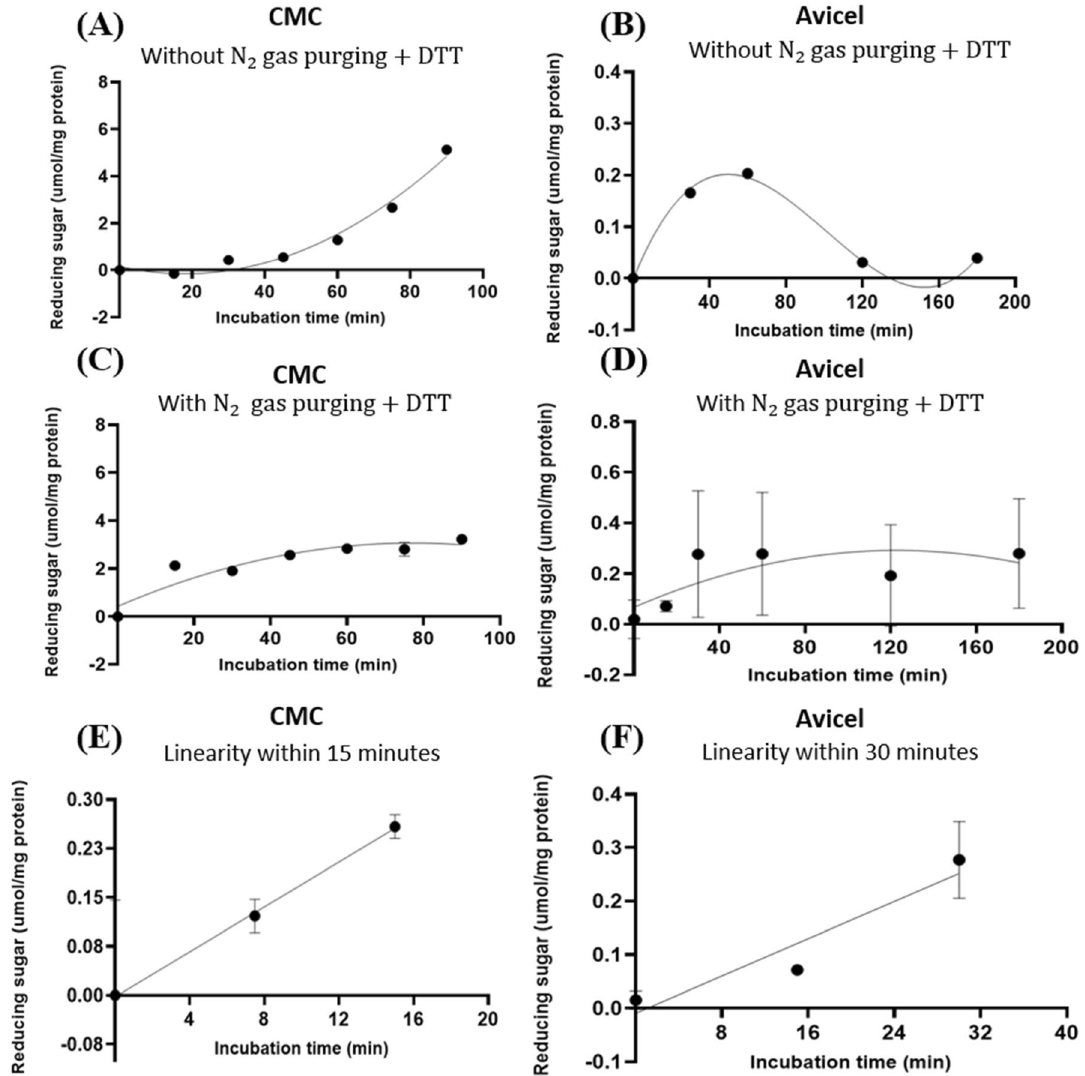
Figure 3. Experiment-1 of the time courses (y, mean ± SE, umol/mg protein) with describing model parameter estimates ± SE ) of crude GH5-tCel5A1 enzyme preparation incubated with carboxymethyl cellulose (CMC) and Avicel as the substrate buffers in the presence or absence of N 2 gas purging and dithiothreitol (DTT) (5 mM) for up to 90–180 min, respectively, in examining the effects of auto-oxidation on GH5-tCel5A1 hydrolysis. (A) Responses (y, mean ± SE , n = 4 at each time point) of the crude GH5-tCel5A1 enzyme preparation incubated with the CMC substrate buffer without N 2 gas purging and the DTT (5 mM) for up to 90 min described Y = − 0.036 ( ± 0.013 ) x − 9.0 e − 4 (cid:31) ± 1.3 e − 4 (cid:30) x 2 according to a quadratic model (model parameter estimates ± SE ) as: , P = 0.472 for the intercept; P = 0.009 for the linear parameter estimate; and P < 0.0001 for the quadratic parameter estimate; R 2 = 0.927, n = 28; (B) Responses (y, mean ± SE , n = 4 at each time point) of the crude GH5-tCel5A1 enzyme preparation incubated with the Avicel substrate buffer without N 2 gas purging and DTT (5 mM) for up to 180 min described according to a quartic Y = 1.564 ( ± 0.481 ) x 2 − 1.041 ( ± 0.279 ) x 3 + 0.191 ( ± 0.049 ) x 4 model (model parameter estimates ± SE ) as: , P = 0.244 for the intercept; P = 0.093 for the linear parameter estimate; P = 0.006 for the quadratic parameter estimate; P = 0.003 for the cubic parameter estimate; and P = 0.002 for the quartic parameter estimate; R 2 = 0.727, n = 20 ; (C) Responses (y, mean ± SE , n = 4 at each time point) of the crude GH5-tCel5A1 enzyme preparation incubated with the CMC substrate buffer with N 2 gas purging with DTT (5 mM) for a total of 90 min established according to a quadratic model (model parameter estimates ± SE ) as: Y = 0.474 ( ± 0.229 ) + 0.067 ( ± 0.012 ) x − 4.6 e − 4 ( ± 1.0 e − 4 ) x 2 ; P = 0.049 for the intercept; P < 0.0001 for the linear parameter estimate; and P = 0.002 for the quadratic parameter estimate; R 2 = 0.837, n = 32; (D) Responses (y, mean ± SE , n = 12 at each time point) of the crude tCel5A1 enzyme preparation incubated with the Avicel substrate buffer with N 2 gas purging and DTT (5 mM) for up to 180 min established according to a quadratic model (model parameter estimates ± SE ) as: Y = 0.004 ( ± 0.001 ) x − 2.0 e − 5 ( ± 7.462 e − 6 ) x 2 , P = 0.006 for the slope estimate and P = 0.038 for the quadratic parameter estimate; r 2 = 0.167, n = 72); (E) the linear part (y, mean ± SE , n = 4 at each time point) (0, 7.5 and 15 min) part of the above -(C) time course experiment with the crude GH5-tCel5A1 enzyme preparation incubated with the CMC buffer at 37 °C and pH 7.4 with N 2 gas y = 0.149 ( ± 0.010 ) x purging and DTT (5 mM) established (model parameter estimates ± SE ) as: , P = 0.096 for the intercept and P < 0.0001 for the slope, r 2 = 0.963, n = 12; and (F) the linear part (y, mean ± SE , n = 12 at each time point) (0, 15 and 30 min) of the above -(D) time course experiment with the crude tCel5A1 enzyme preparation incubated with the Avicel substrate buffer at 37 °C and y = 0.008 ( ± 0.002 ) x pH 7.4 with N 2 gas purging and DTT (5 mM) established (model parameter estimates ± SE ) as: , P = 0.909 for the intercept and P < 0.0001 for the slope, r 2 = 0.358, n = 36